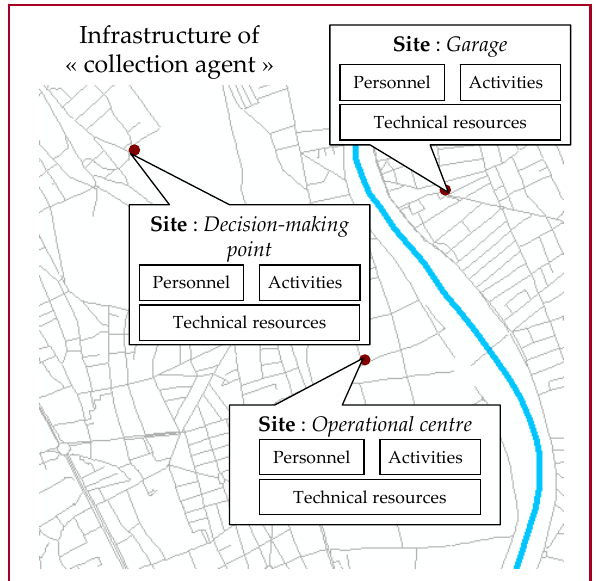
Figure 4: Example of infrastructure’s organization 10 Fig. 4. Example of an infrastructure’s